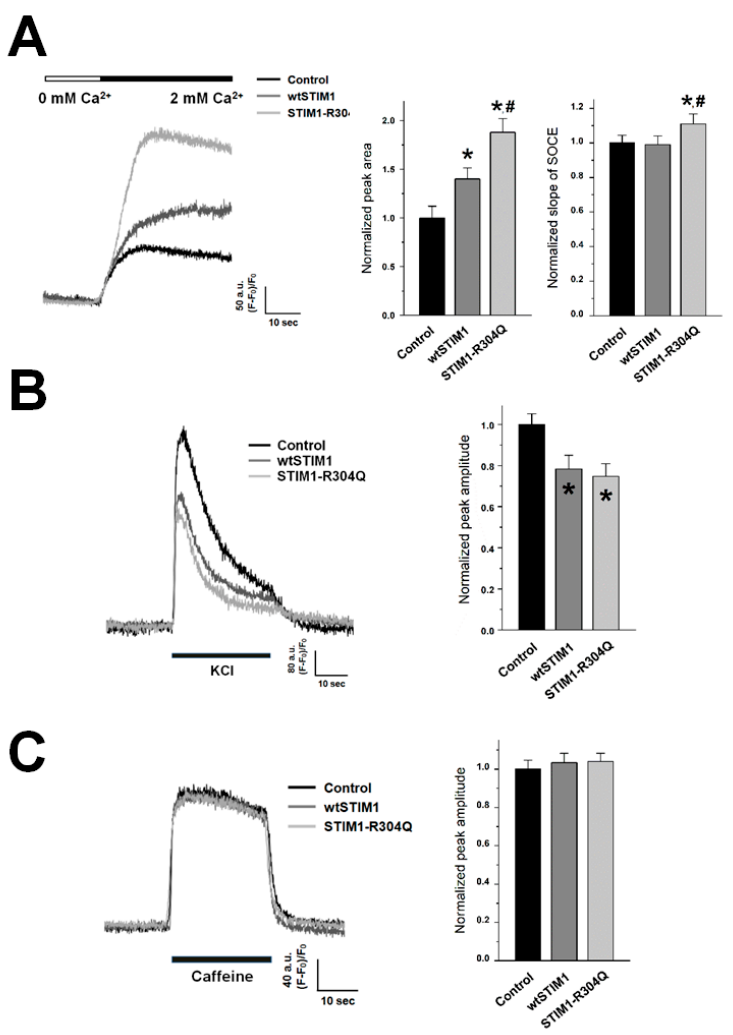
Figure 2. Ca 2+ entry through the SOCE mechanism and intracellular Ca 2+ release: ( A ) Ca 2+ of the SR in wtSTIM1- or STIM1-R304Q-expressing myotubes was depleted by treatment with thapsigargin (2.5 µ M) in the absence of extracellular Ca 2+ , and extracellular Ca 2+ (2 mM) was then applied to the myotubes to induce SOCE. The experimental mean values were normalized to the mean values of the control (for the area under the peaks on the left-hand side and for the slope in the rising phase of SOCE on the right-hand side, Table 1). KCl ( B ) or caffeine ( C ) was applied to the myotubes, and intracellular Ca 2+ release from the SR to the cytosol through RyR1 was measured. The experimental values were normalized to the mean values of the control (Table 1). A representative trace for each group is shown ( A – C ). * Significant difference compared with the control ( p < 0.05). # Significant difference compared with wtSTIM1 ( p < 0.05).